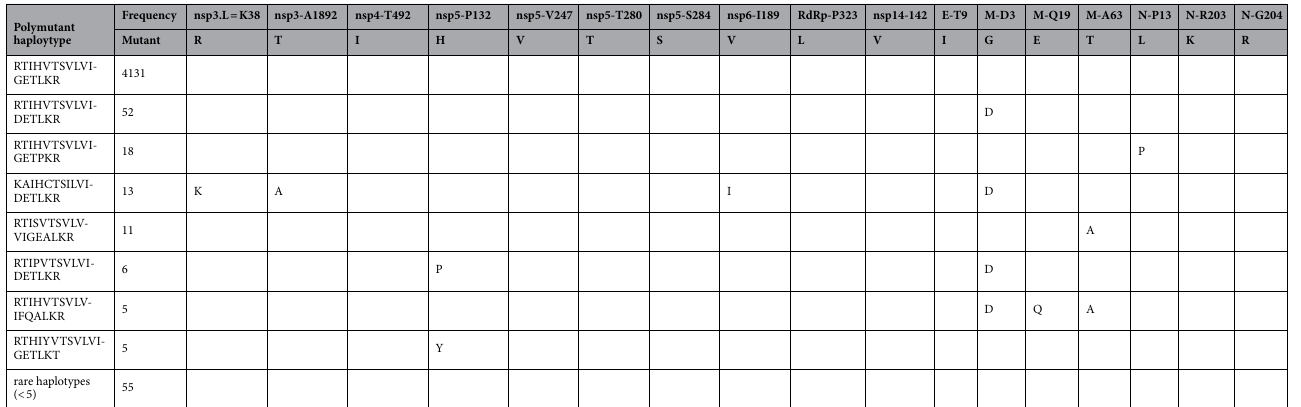
Table 2. Haplotype frequencies of 17 polymutants (K38A, 1892) of nsp3, T492 of nsp4, (P132, V247, T280, S284) of 3C-like proteinase, I189 of nsp6, P323 of RdRp, I42 of Exonuclease, T9 of envelope protein, (D3, Q19, A63) of membrane glycoprotein, (P13, R203, G204) of nucleocapsid phosphoprotein, all of which locate outside of the spike gene, observed among all Omicron viruses.